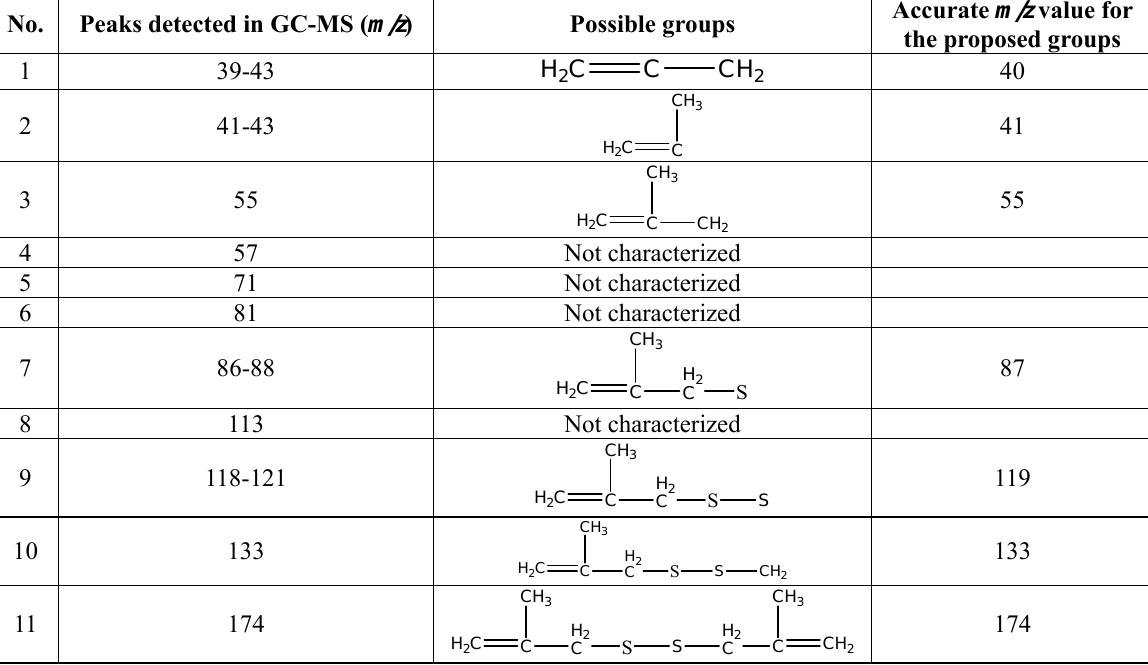
Table 1. GC-MS analysis